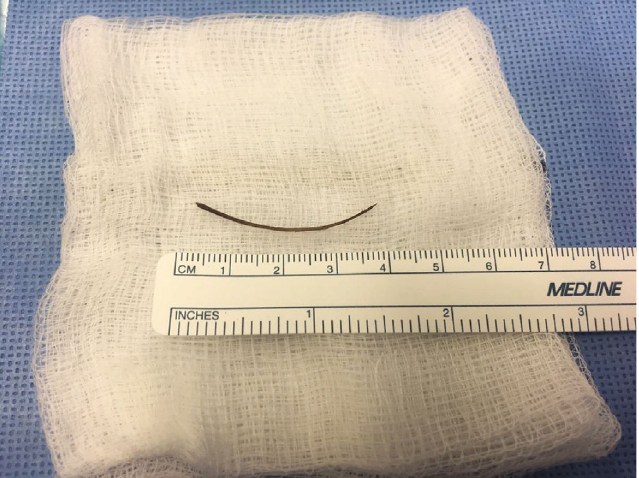
Figure 3: Postoperative fi sh bone specimen in case number